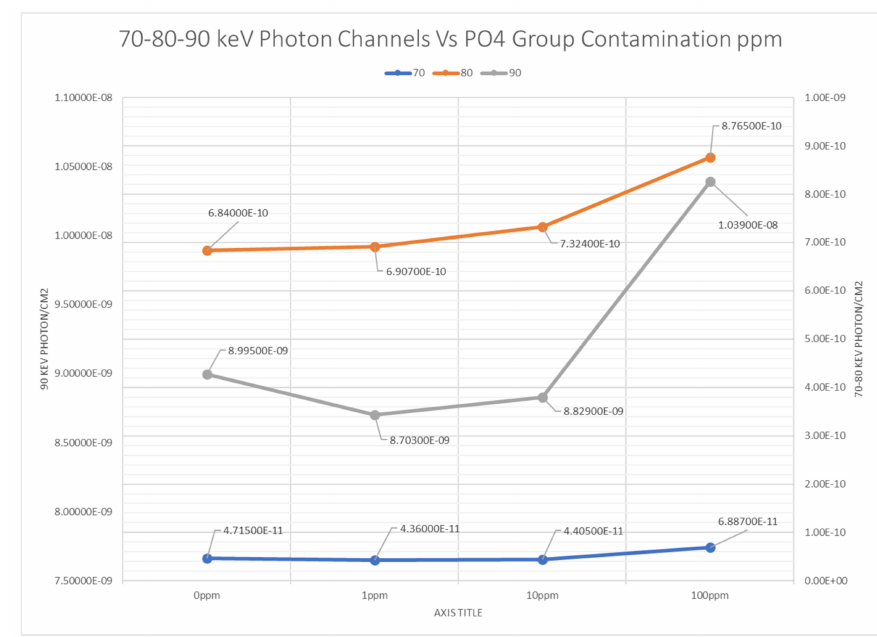
Figure 15. High band photon spectrum B1-air sample vs. contamination PO4